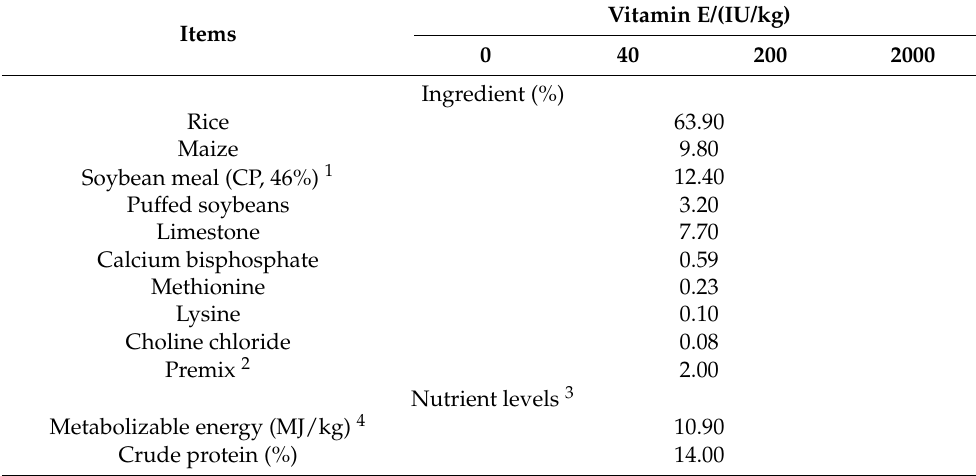
Table 1. Composition and nutrient levels of basal diets (as-fed